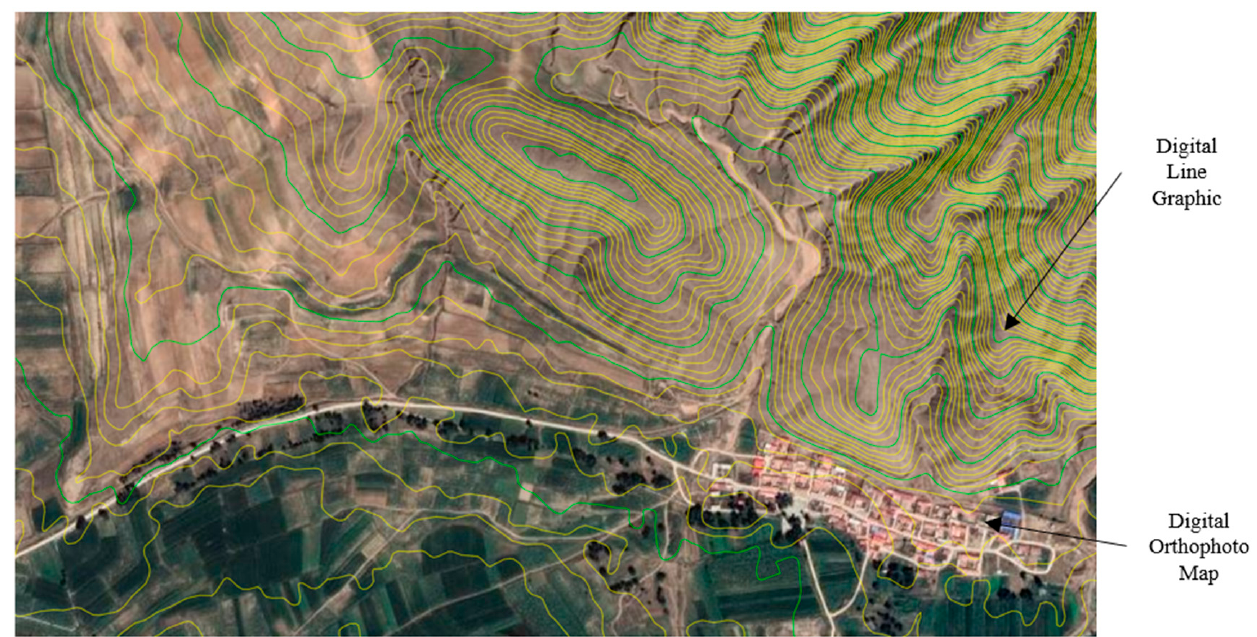
Figure 1. Effect diagram of digital elevation model. Figure 1. E ff ect diagram of digital elevation model.